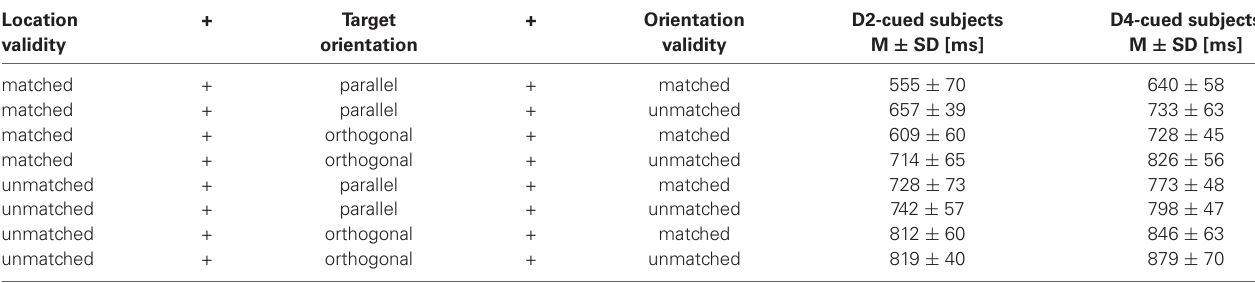
Table 1 | Reaction times grouped with respect to target properties .